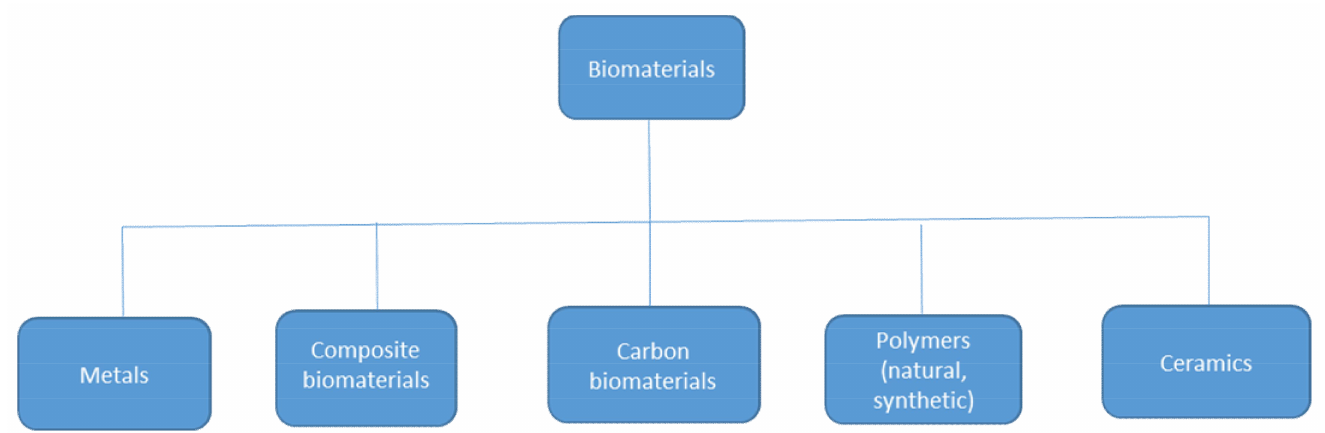
Figure 1. General division of